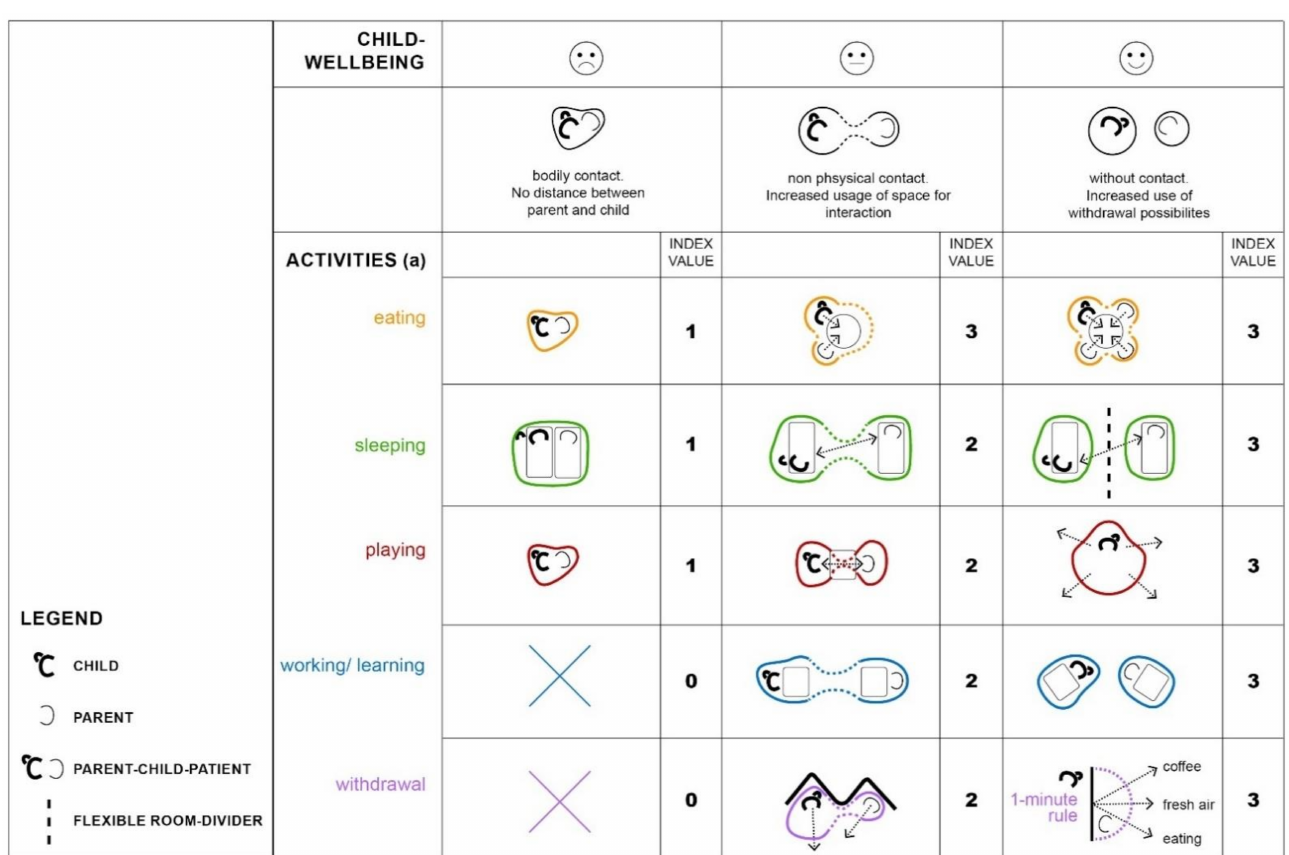
Figure 3. Graphical depiction of the relationship between child well-being and architectural determinants, divided into five daily